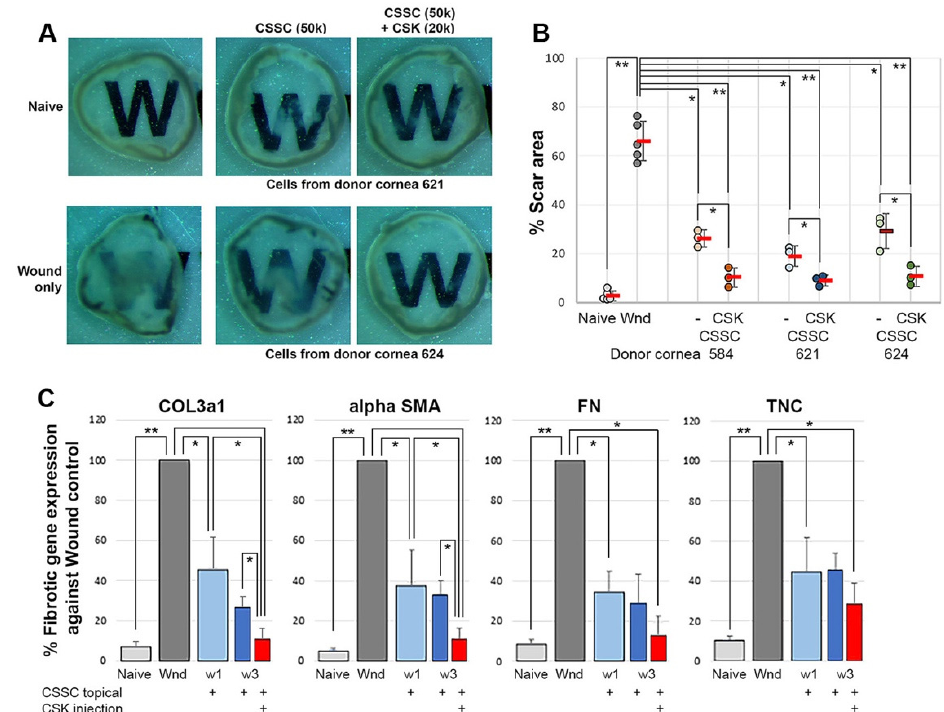
Figure 7. Combined CSSC and CSK treatments on mouse corneas after epithelial-stromal injury. ( A ) Isolated cornea images. Corneas after combined cell treatment were more clear than single CSSC-treated corneas, showing minor haze. Wounded corneas had extensive scarring. ( B ) Further reduction in the percentage of the scar area after combined cell treatment, when compared to single CSSC treatment. The experiment was performed using 3 different pairs of CSSC and CSK from the same donor corneas (* p < 0.05, ** p < 0.01). ( C ) Fibrosis gene expression by qPCR (* p < 0.05, ** p < 0.01,